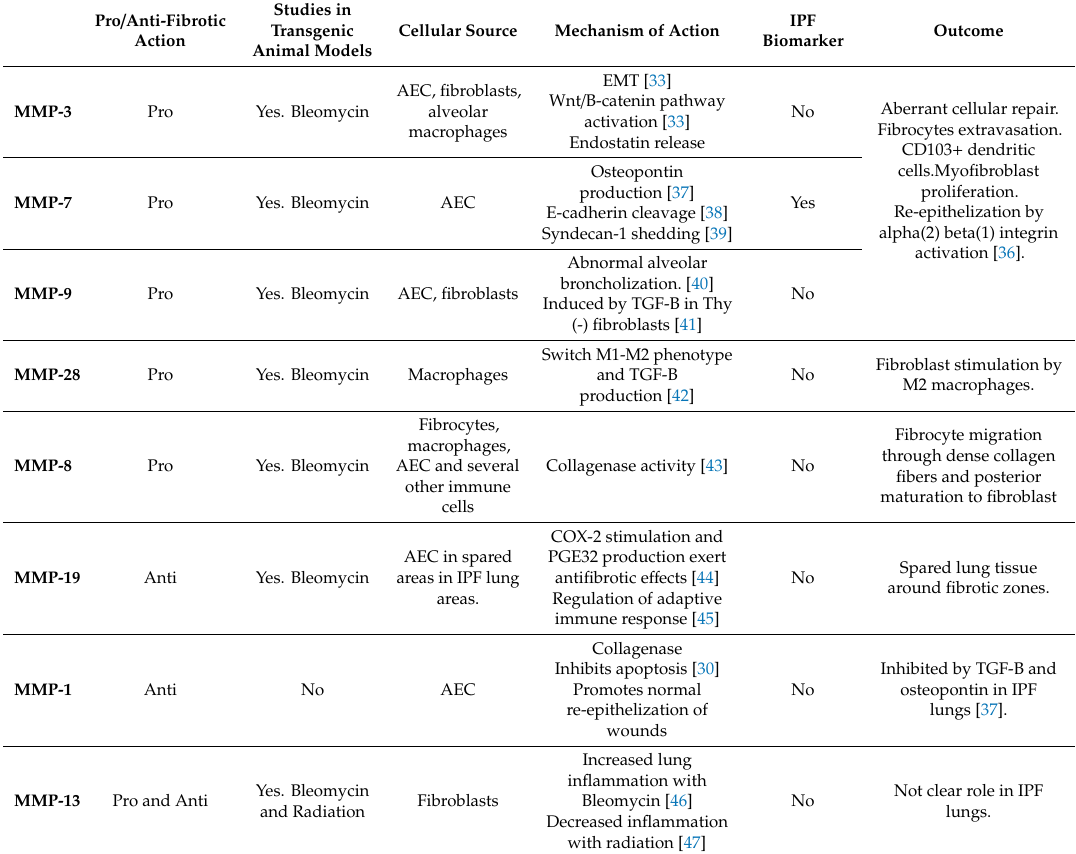
Table 1. Upregulated Metalloproteinases in Pulmonary Fibrosis. AEC: alveolar epithelial cells, COX: cyclooxygenase, EMT: epithelial-mesenchymal transition, TGF- β : tumor growth factor β , IPF: idiopathic pulmonary